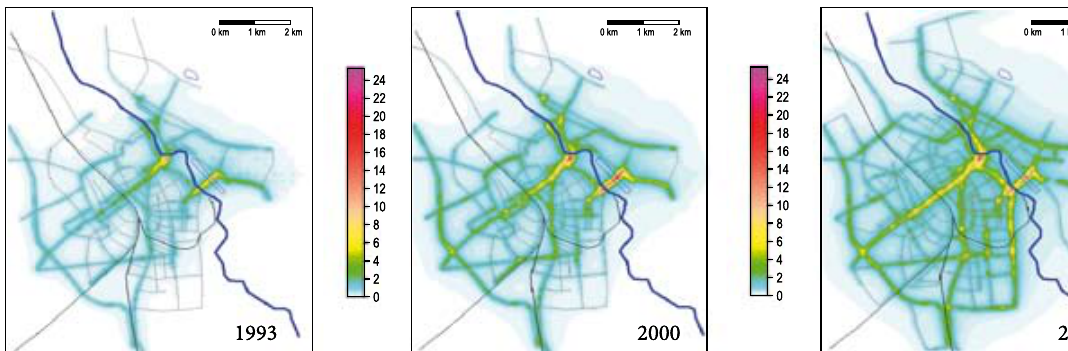
fig. 4. Annual concentration of PM 10 , μg/m 3